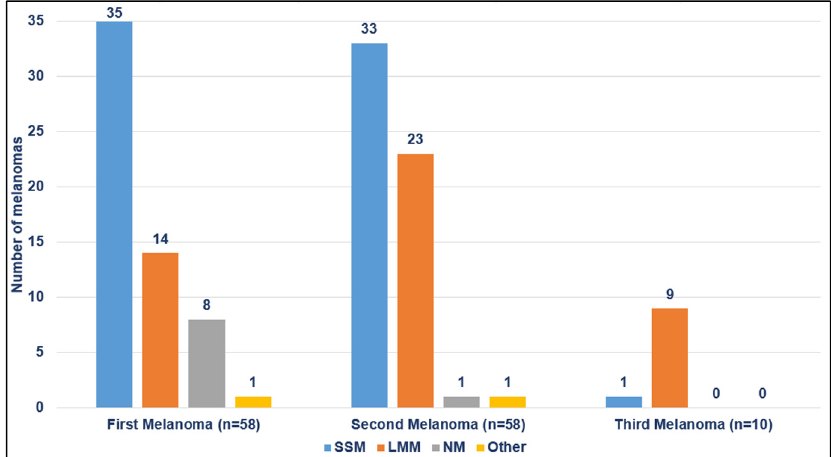
Figure 3. Histologic subtype of first and subsequent primary melanomas.